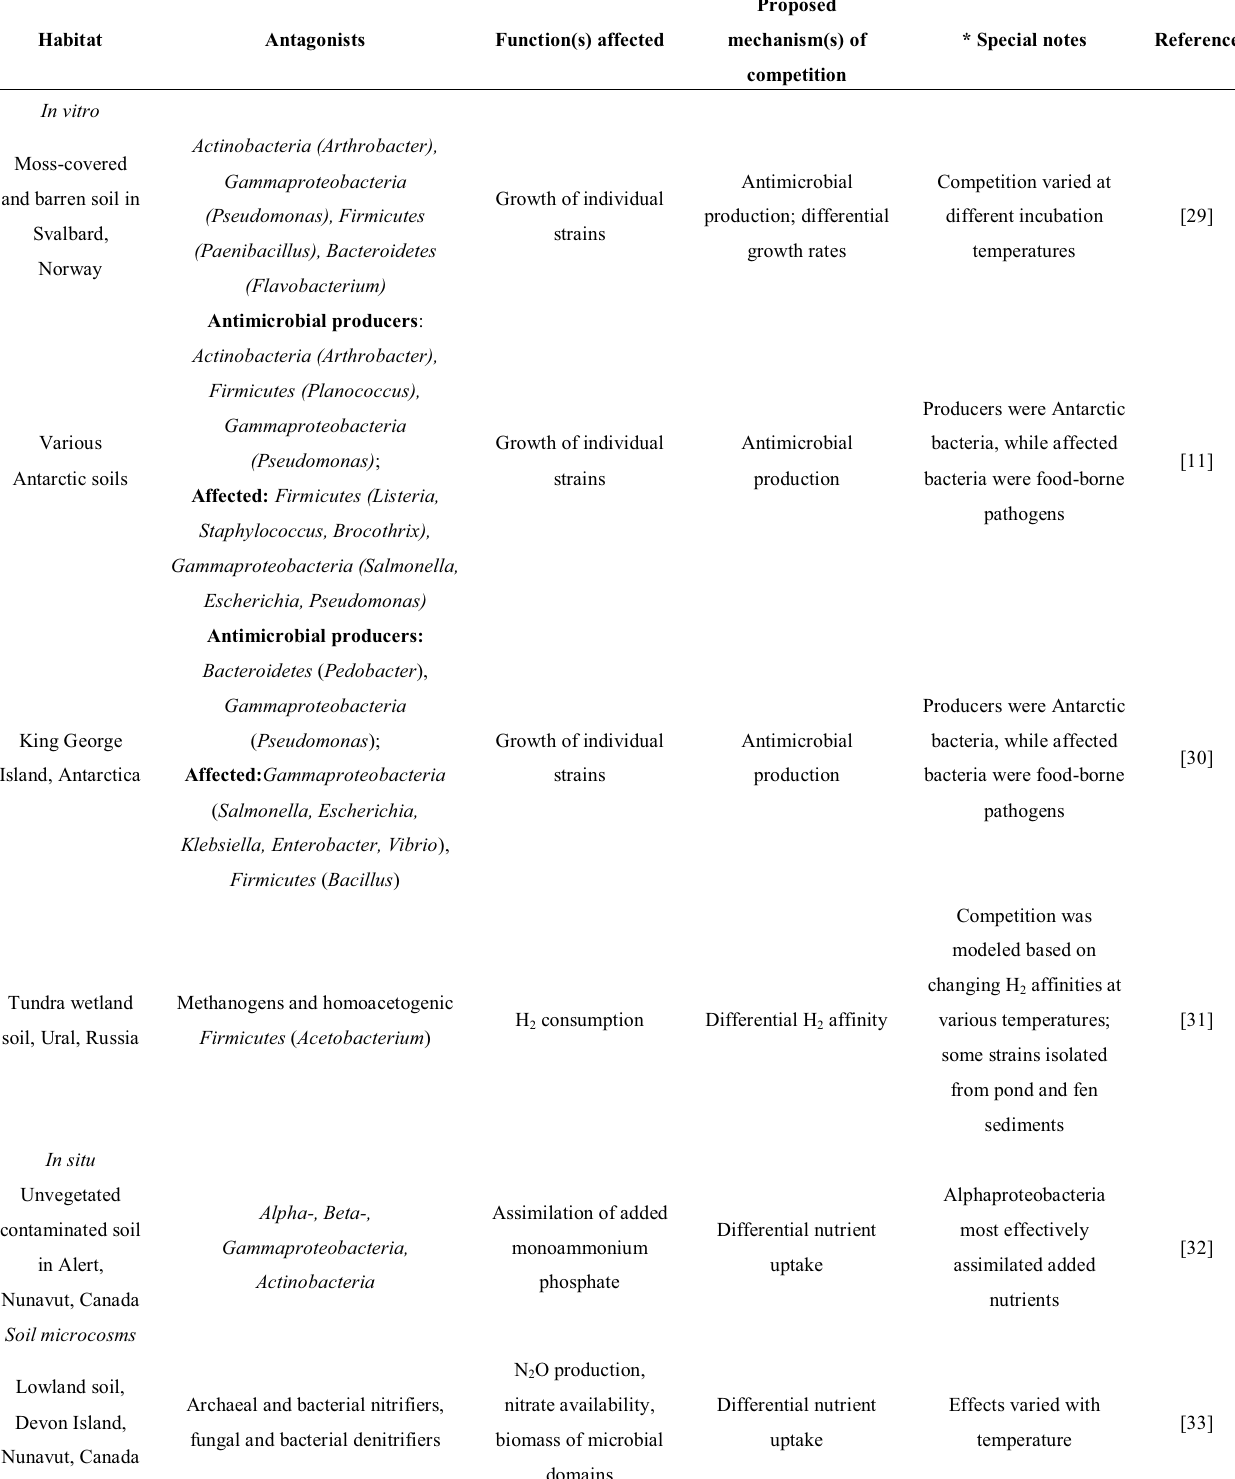
Table 1. Studies that have examined intermicrobial competition in polar